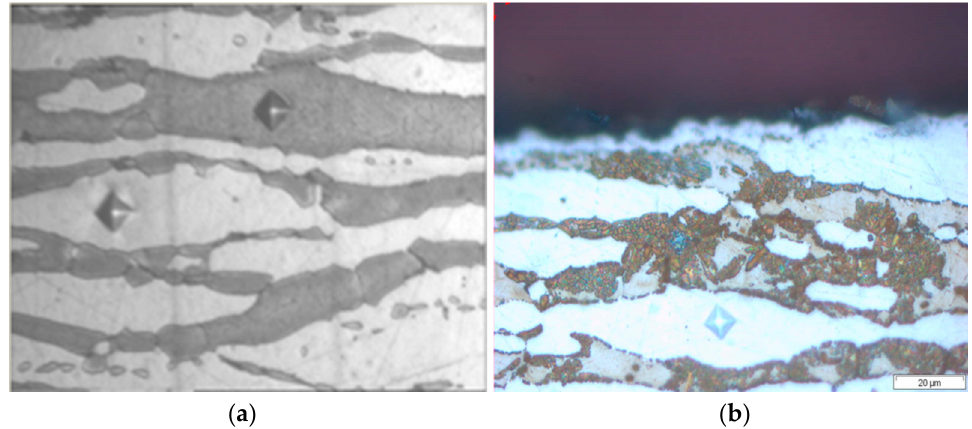
Figure 4. Optical micrograph of the Vickers micro-indentations in austenite phase (white) and ferrite phase (grey) for sample S1 ( a ); Optical micrograph of the Vickers micro-indentations in austenite phase (white) and sigma phase (brown) for the sample S3 ( b ).